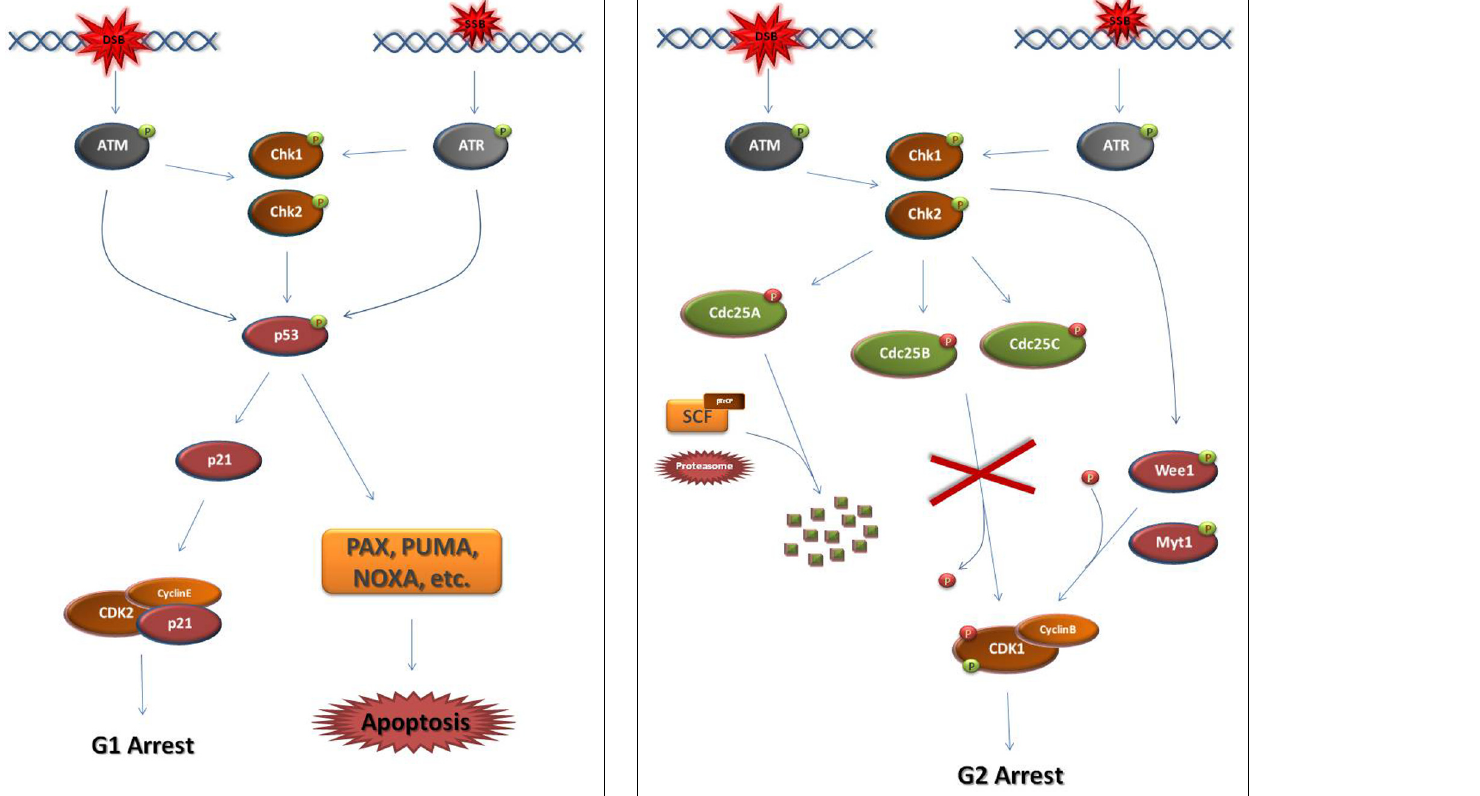
(HR) and non-homologous end joining (NHEJ; Aguilera and